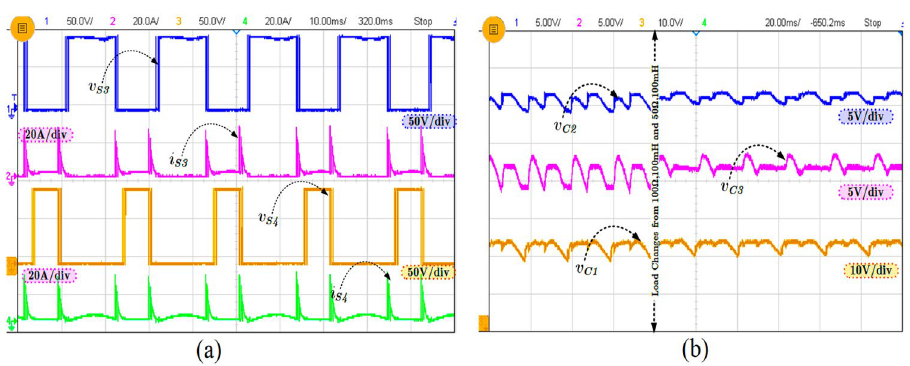
Figure 10. Experimental result of ( a ) the switch voltage and current and ( b ) capacitor voltages (C 1 –C 3 ).